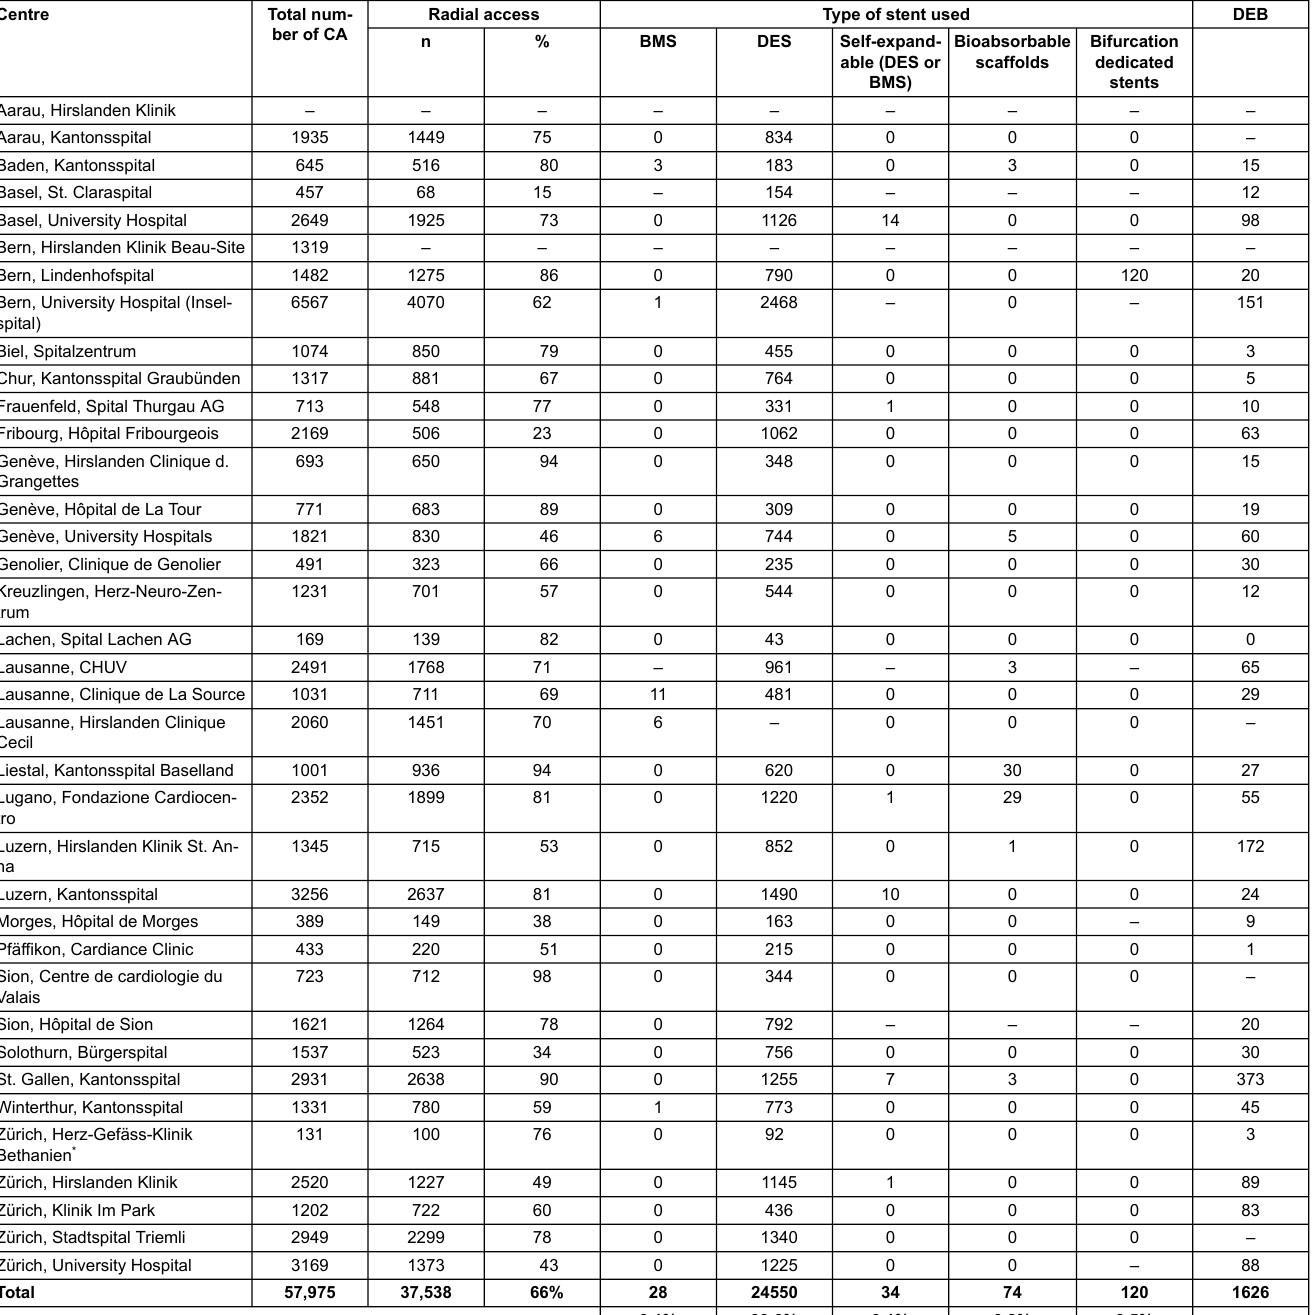
Table 3: Percutaneous coronary intervention details. Centre